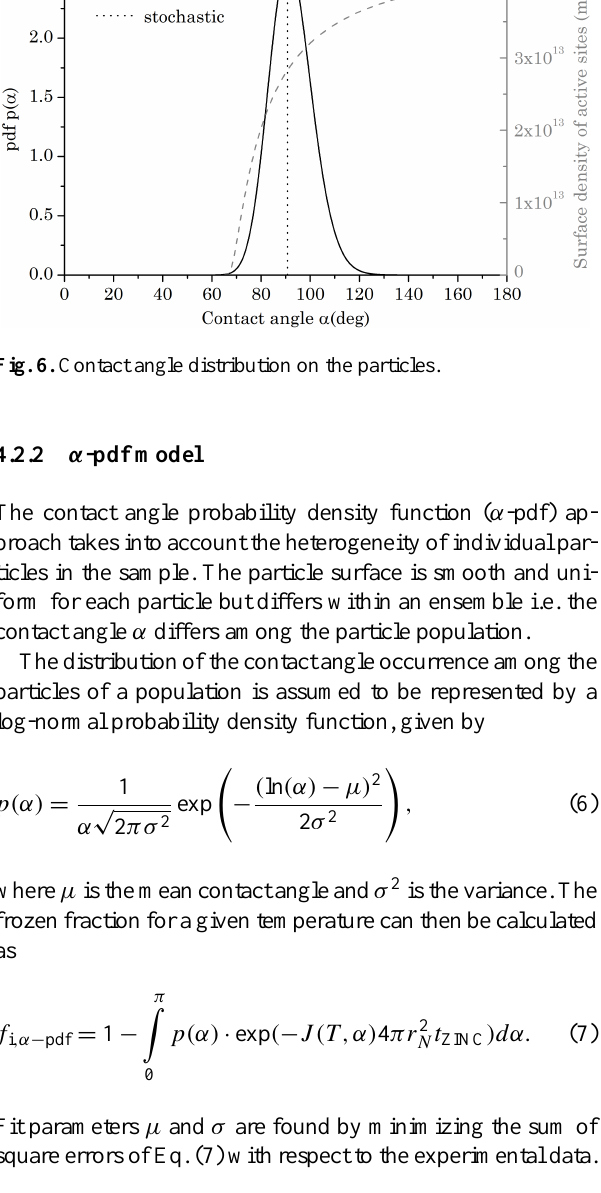
Table 2. Fit parameters obtained for the four models described in Sects. 4.2–4.3. The root mean square errors (RMSE) between the fit curves and the data are given in the last